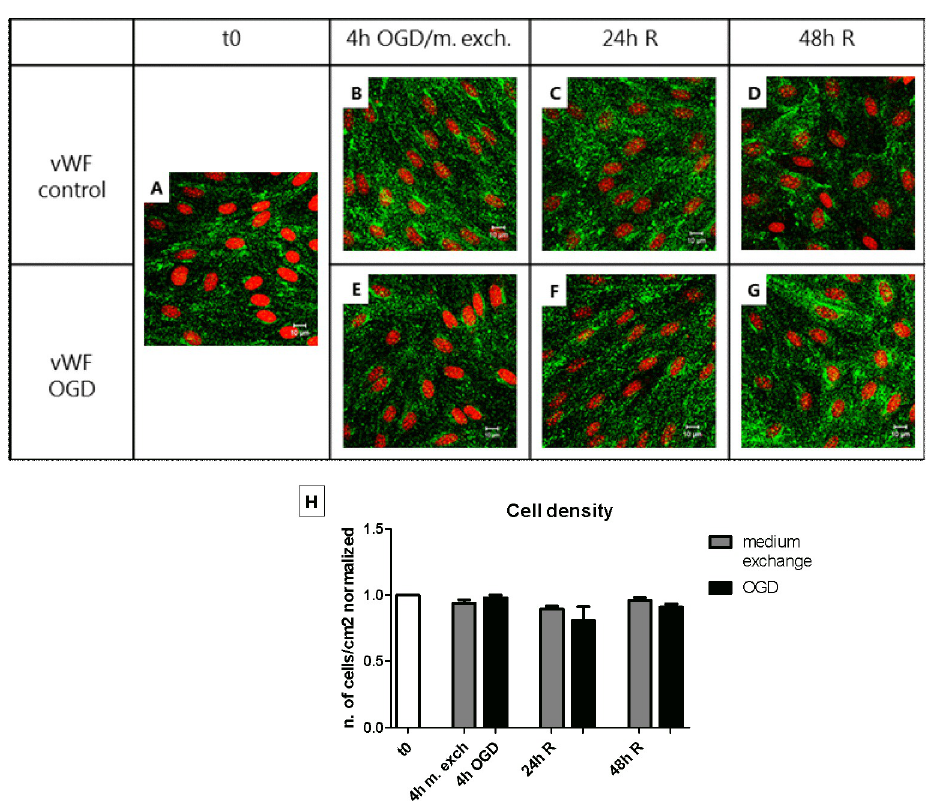
Fig 3. Immunocytochemical evaluation of endothelial cell monolayer purity and determination of the cell density along the oxygen-glucose deprivation (OGD) and medium exchange protocols. Endothelial cell monolayers co- cultured with astrocytes were treated with OGD or medium exchange and reperfused for 24/48 h. (A-G) For each condition, the cells were fixed and stained with an antibody anti-vWF (green) and counterstained with propidium iodide for the nuclei (red). Bars = 10 μ m. N = 1; n = 3. (H) For each condition, the cell density expressed as number of cells per cm 2 was calculated as stated in the “Materials and methods” section. Bar graphs represent means normalized to t0 and error bars are +SEM. N = 5, n = 3–4. The white bar shows the value at t0, the gray bars show the cells subjected to medium exchange, while the black bars show the OGD treated cells. Columns were compared to t0 using one-way ANOVA and Dunnett’s multiple comparison post-test. Bonferroni’s post-test was utilized to compare each pair of columns.